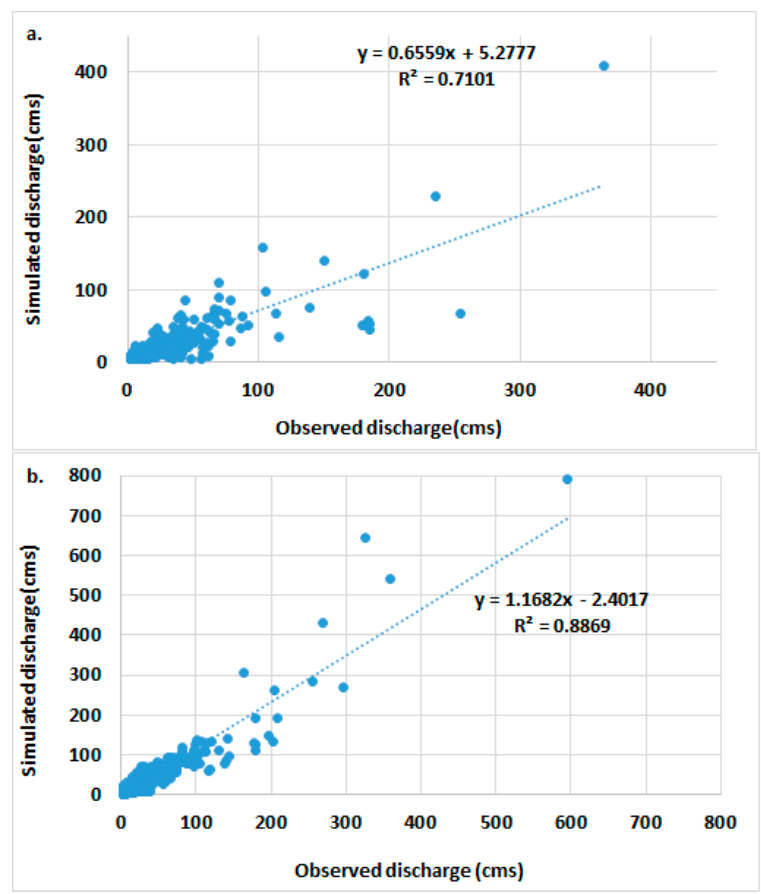
Figure 4. Scatter plot of daily river discharge for calibration ( a ) from 1 January, 2006 to 31 December, 2008 and ( b ) the validation period from 1 January, 2009 to 31 December, 2010.